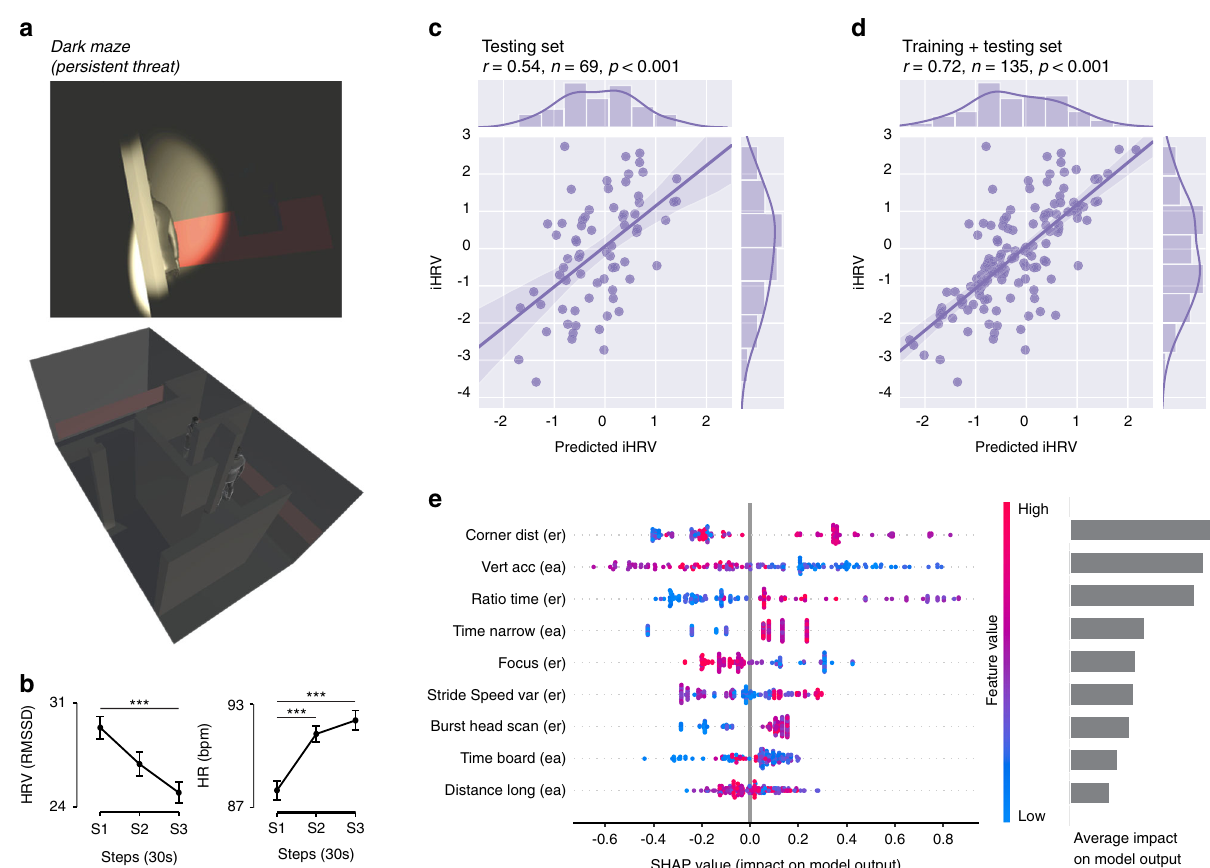
Fig. 2 Stressful virtual reality scenario and model prediction of cardiac stress responses from behavior. a Scenario 3: Dark maze, aimed at eliciting heightened physiological responses. b Heart rate (HR) and heart rate variability (HRV, the RMSSD formula) over time (three blocks of 30 s each) during dark maze exploration. N = 135 participants examined over three consecutive blocks of 30 s (S1, S2, and S3). Data are presented as mean values ± SEM (vertical lines). A repeated measures analysis of variance (rm-ANOVA) was performed for both HR and HRV data sets. Post hoc tests were performed with two-sided paired t tests, with p values corrected for multiple comparisons (three comparisons) with the Holm correction. *** p value <0.001. Exact p values and statistics are presented in Supplementary Information section “ Statistics for physiology in exploration scenarios ” , Tables S6 – 7. Correlation between the XGBoost model ’ s prediction and the integrated HRV index (iHRV) for the test set c and train + test set d . e SHAP values for the trained model, calculated for each subject. The nine most discriminating features (from the 18 used by the model) were the minimum distance to the corners of the empty room [Corner dist (er)], vertical acceleration in the elevated alley [Vert acc (ea)], ratio between time in the center and time in the periphery of the empty room [Ratio time (er)], time spent on the narrowest ledge of the elevated alley [Time narrow (ea)], movement focus in the empty room [Focus (er)], variability in the stride speed in the empty room [Stride speed var (er)], number of head scans while walking in the empty room [Walking head scan (er)], time spent on the starting board in the elevated alley [Time board (ea)], maximal longitudinal distance reached in the elevated alley [Distance long